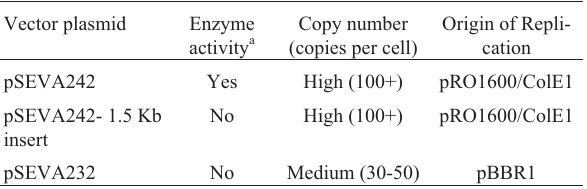
Table 1 - Presence or absence of yellow halos indicative of vector-intrin-